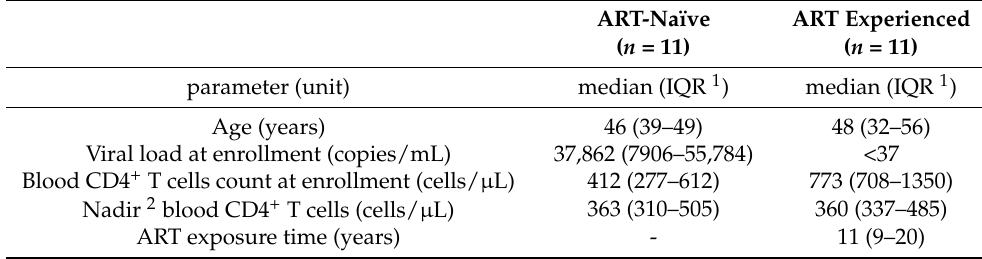
Table 1. Age, immune and virologic profile of study